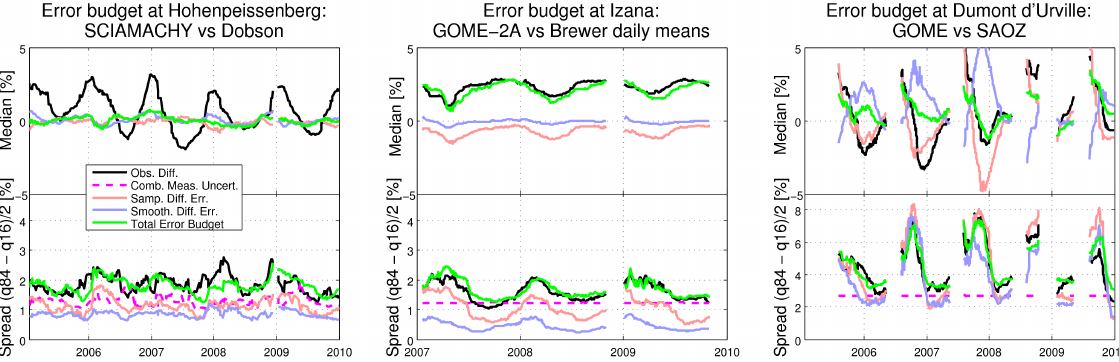
Figure 6. Running 3-month comparison median and spread (as derived from 16 and 84% quantiles), both observed (black) and simulated (green), and the decomposition in the different metrological components of the simulations. Note the larger range of the bottom right-hand